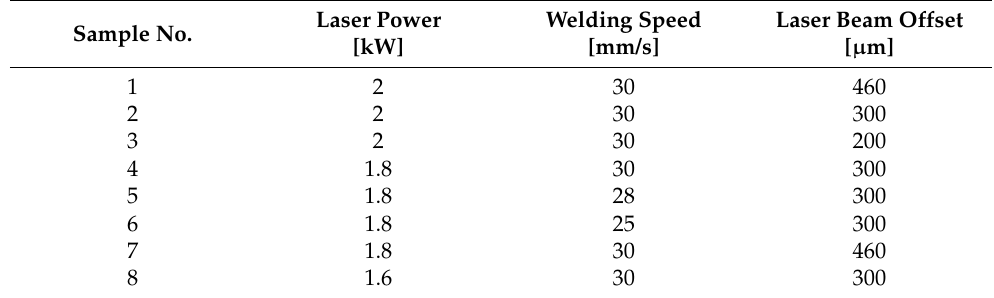
Table 4. Welding parameters applied for the experimental preparation of welded–brazed joints. Sample